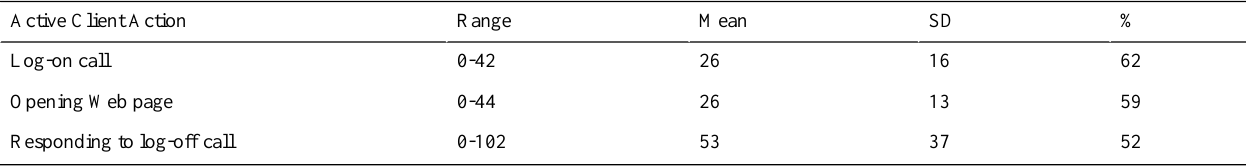
Table 3. Mean number of active client actions for three components of HE (n = 144) a